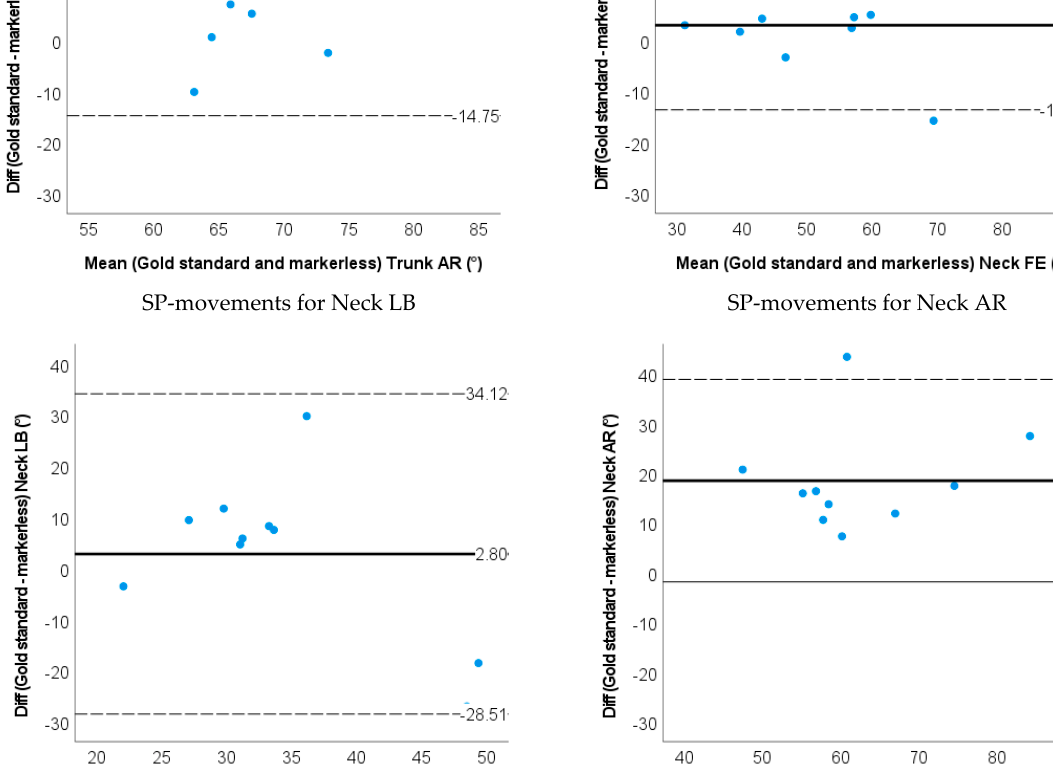
Figure 9. Bland − Altman plots for the ROM of the trunk and neck angle obtained by the gold standard and markerless method for SP-movements. The solid line represents the mean difference, and the dashed line represents the 95% limits of agreement.